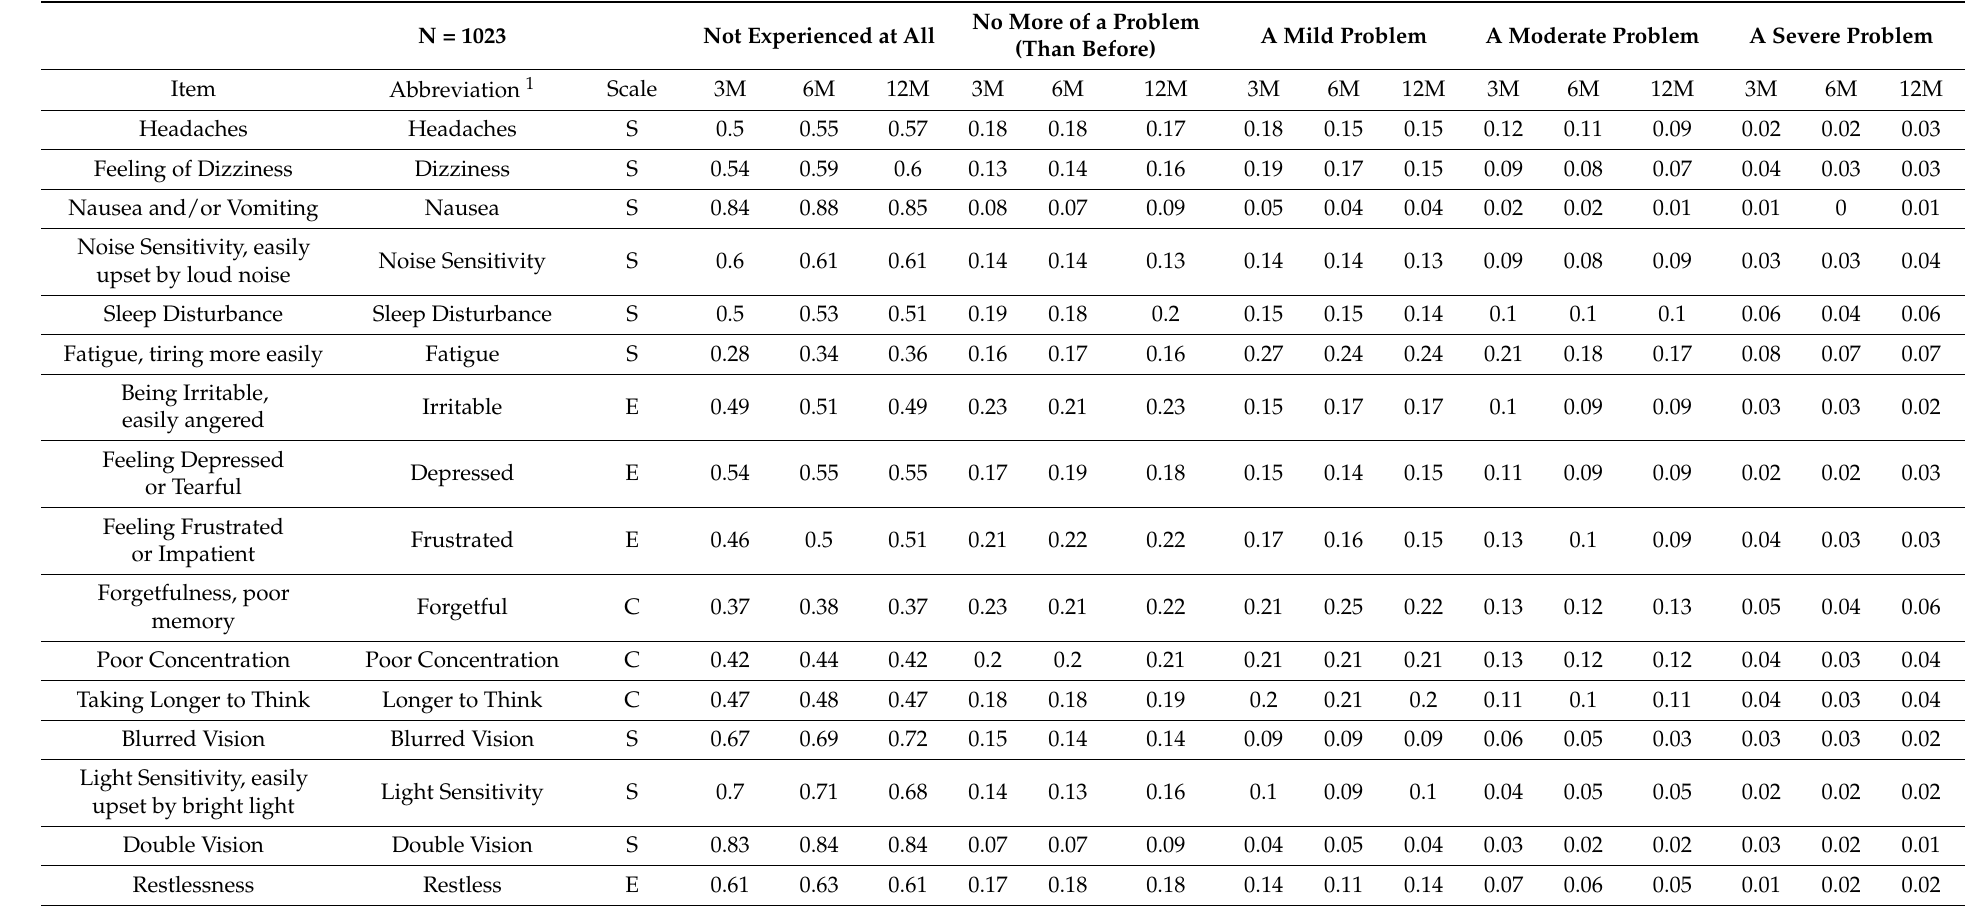
Table 2. Proportions for each level of response by time point (3, 6 and 12